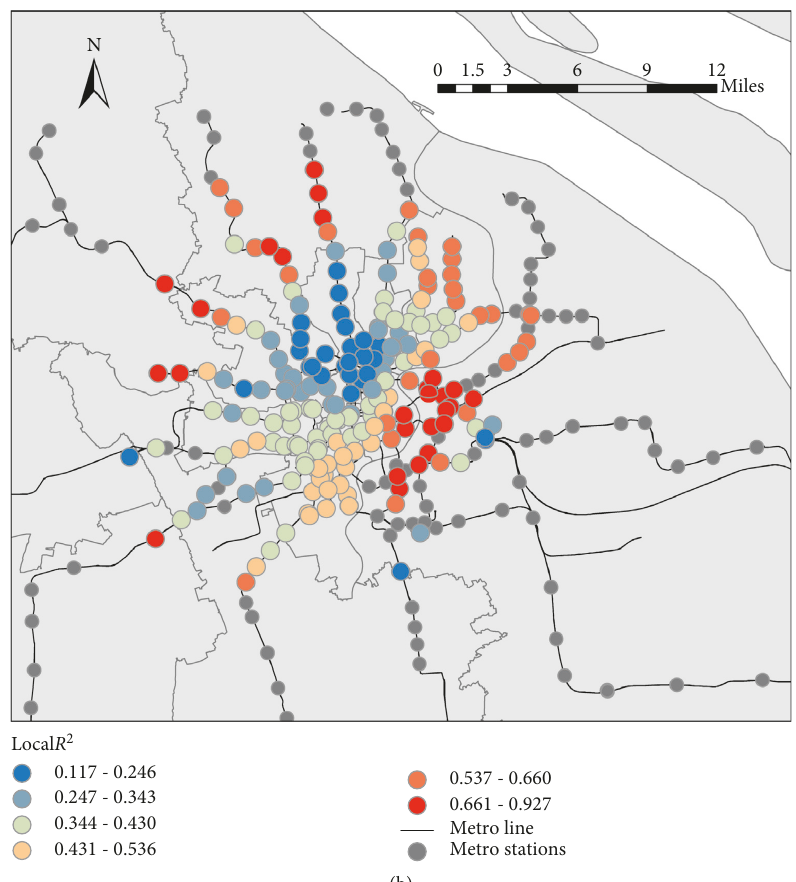
Figure 6: GWR performance evaluation: (a) GWR condition number and (b) GWR local R 2